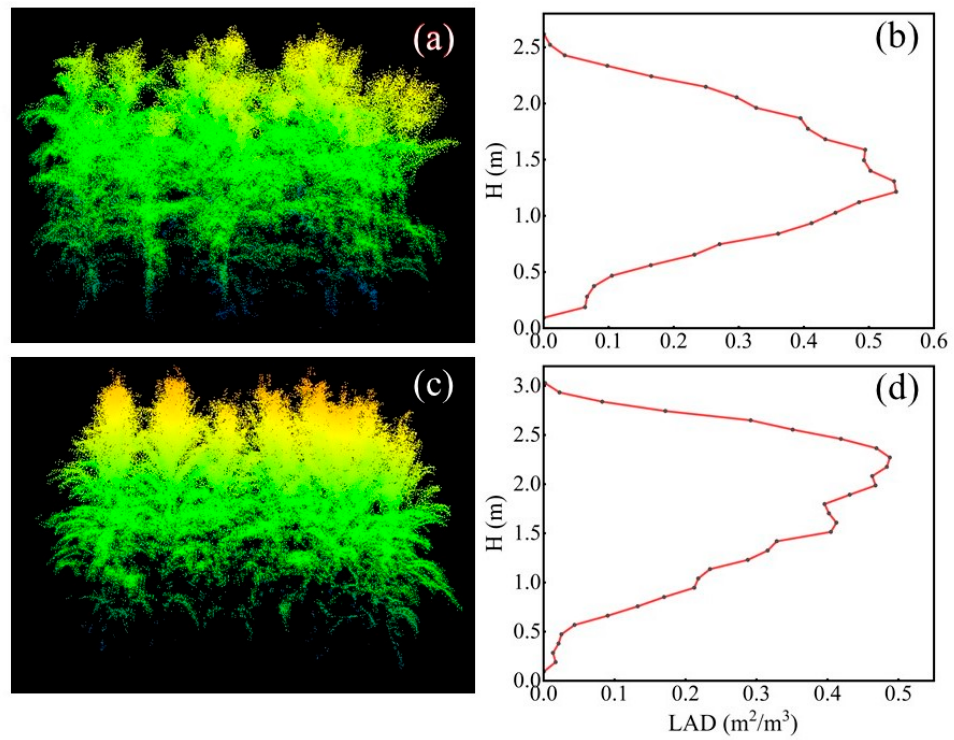
Figure 16. Missing point clouds for different planting densities in the DLS platform. ( a , b ) are the maize point cloud data and LAD distribution curves at D2; ( c , d ) are the maize point cloud data and LAD distribution curves at D5.